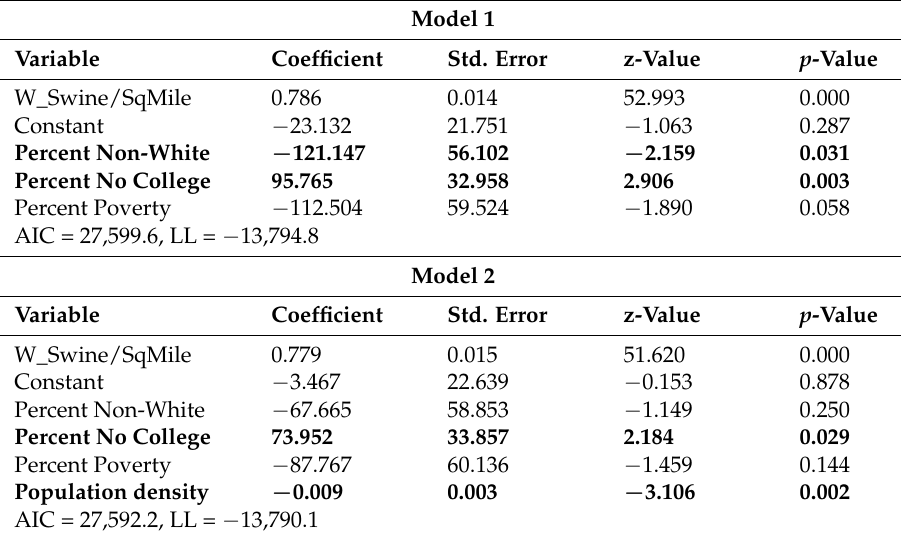
Table 3. Results of the spatial multivariable regressions indicating the relationship between EJ variables and swine AU density in CBGs (Model 1) and the relationship between EJ variables and swine AU density after controlling for population density (Model 2). Statistically significant variables are bolded. AIC = Akaike Information Criterion; LL = log likelihood. Model 1 Variable Coefficient Std.